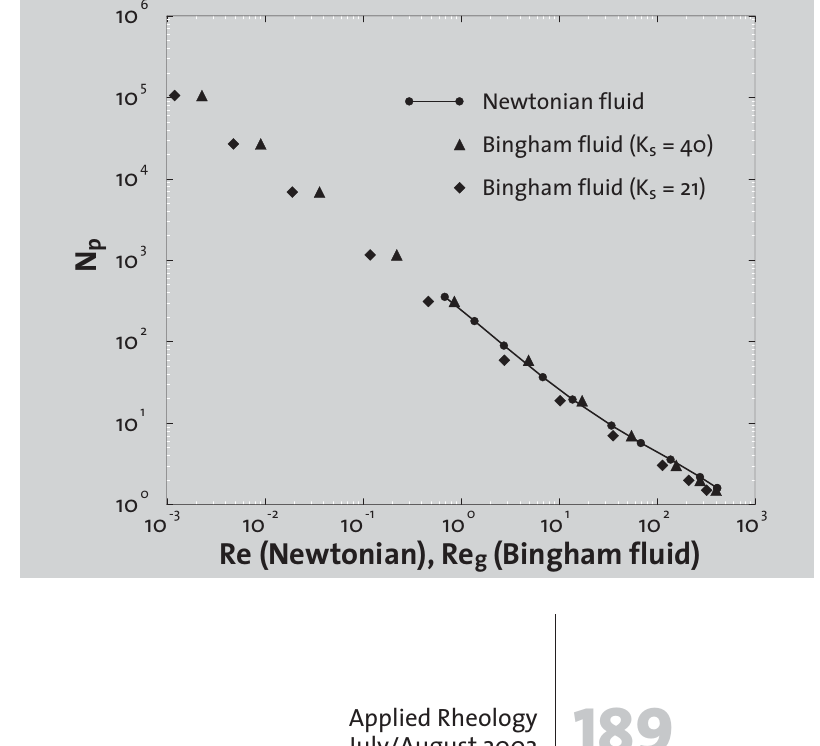
Fig. 11 (right below): Power number versus generalised Reynolds